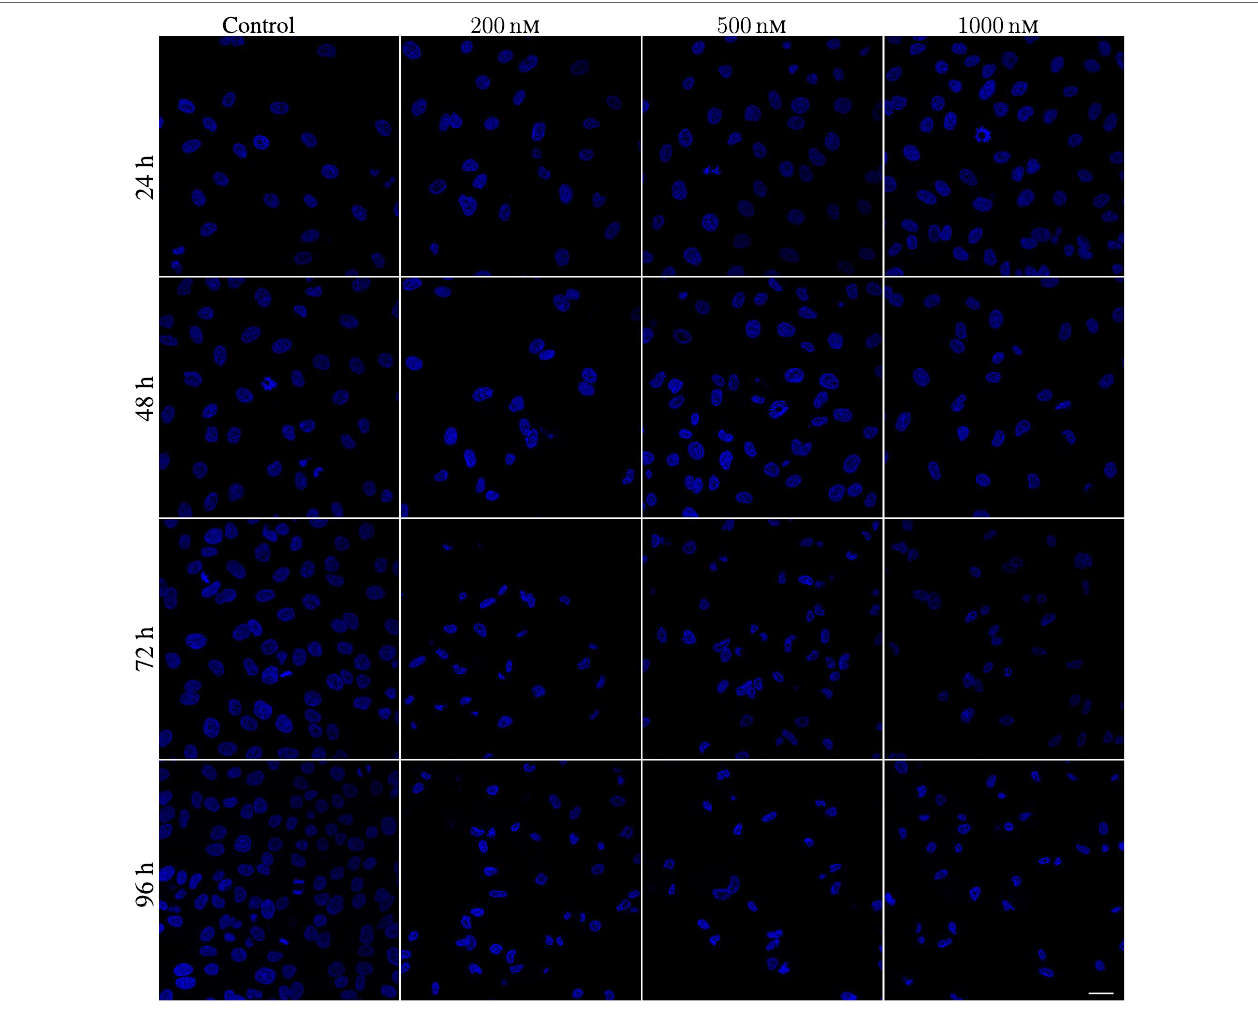
FigUre 18 | Hoechst labeling of A549 cells showing nuclear envelope defects after being exposed to 200, 500, and 1,000 nM YTX for 24, 48, 72, and 96 h. First column: Hoechst labeling for control cells showing normal nuclei with normal nuclear envelopes. Second, third, and fourth columns show cells exposed to 200, 500, and 1,000 nM, respectively. Note deformed nuclei with lobulated nuclear envelopes in YTX-treated cells. Scale bar: 25